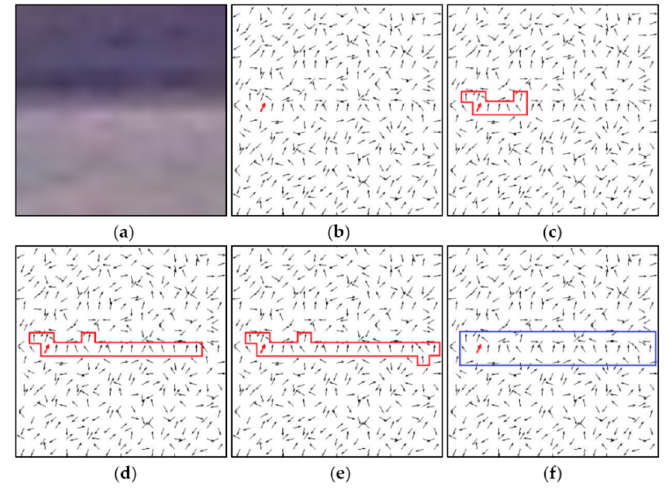
Figure 5. Region growing process based on gradient orientation. ( a ) is the original image of the local region; ( b – d ) show the LSR in growing; ( e ) is the final LSR in the end of region growing; ( f ) is minimum enclosing rectangle of the LSR.